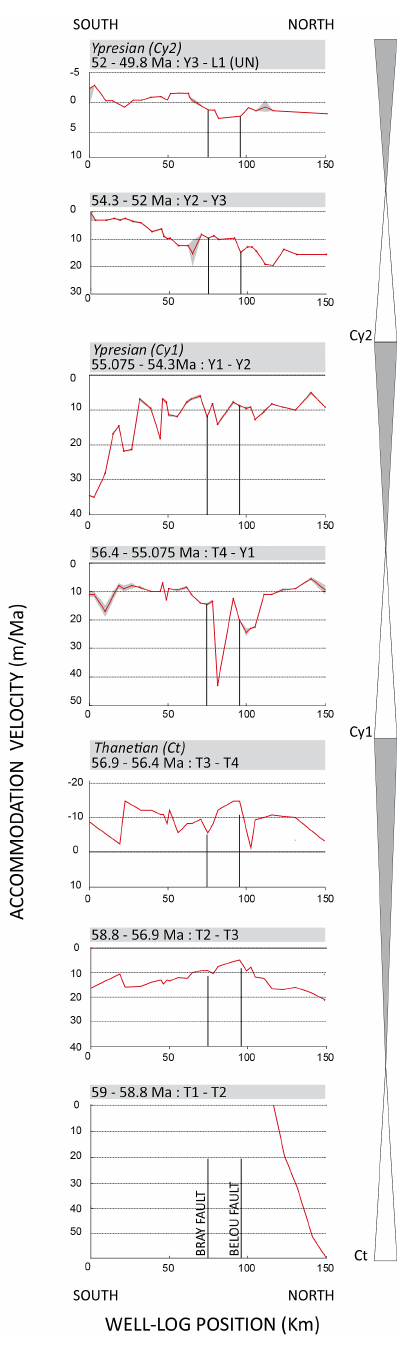
Figure 5. Accommodation space rate (mMa − 1 ) for Palaeocene– early Eocene times along the south–north transect (Fig. 4) for each time interval. Each curve (red line) represents the accommodation space. Error bars (in grey) take different compaction rates into ac- count (see Fig.